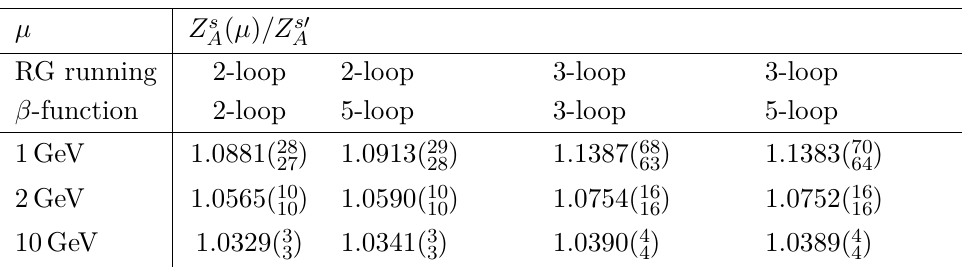
( µ ) /Z s 0 = Z s ( µ ) /Z s ( ∞ ) , computed according to eq. (5.14) for A A A A